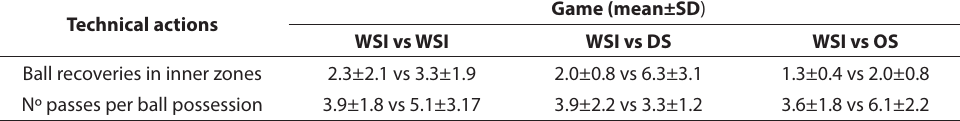
TABLE 1 Descriptive results from the comparisons among considered game scenarios for technical